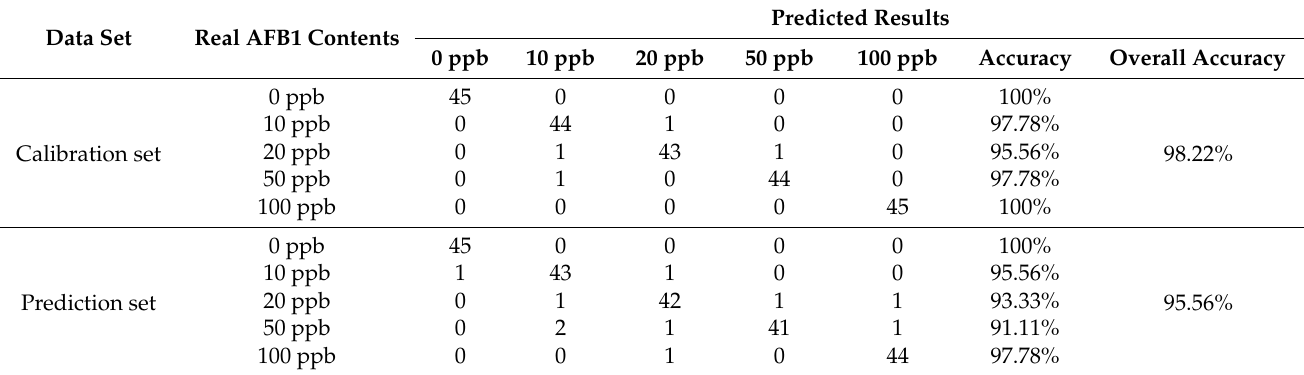
Table 2. Confusion matrix of the predicted results of AFB1